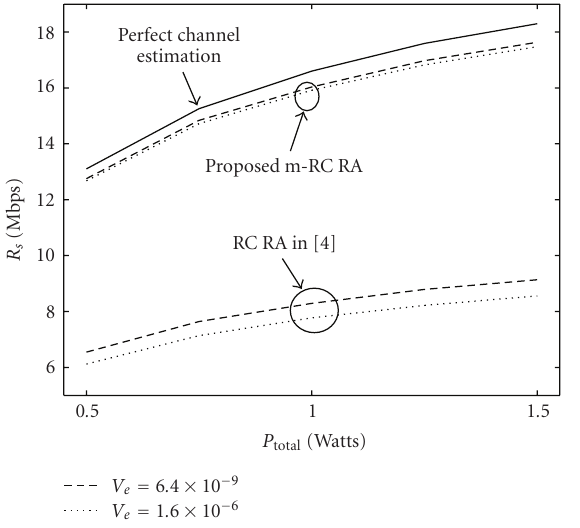
Figure 2: Total bit rate, R s , as a function of P total for the m-RC RA algorithm with P o = 10 − 3